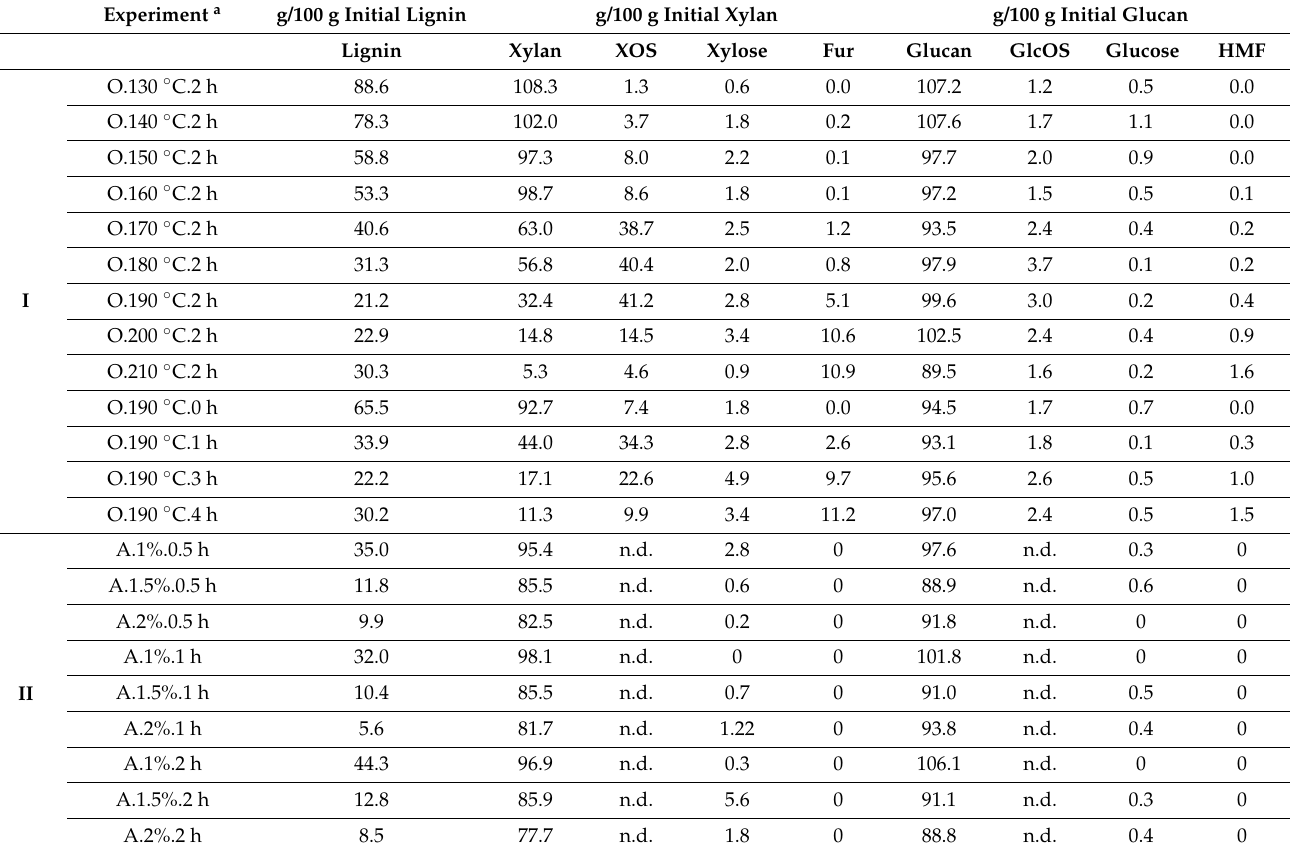
Table 2. Yield of lignin, xylan, glucan, and their derivatives for different